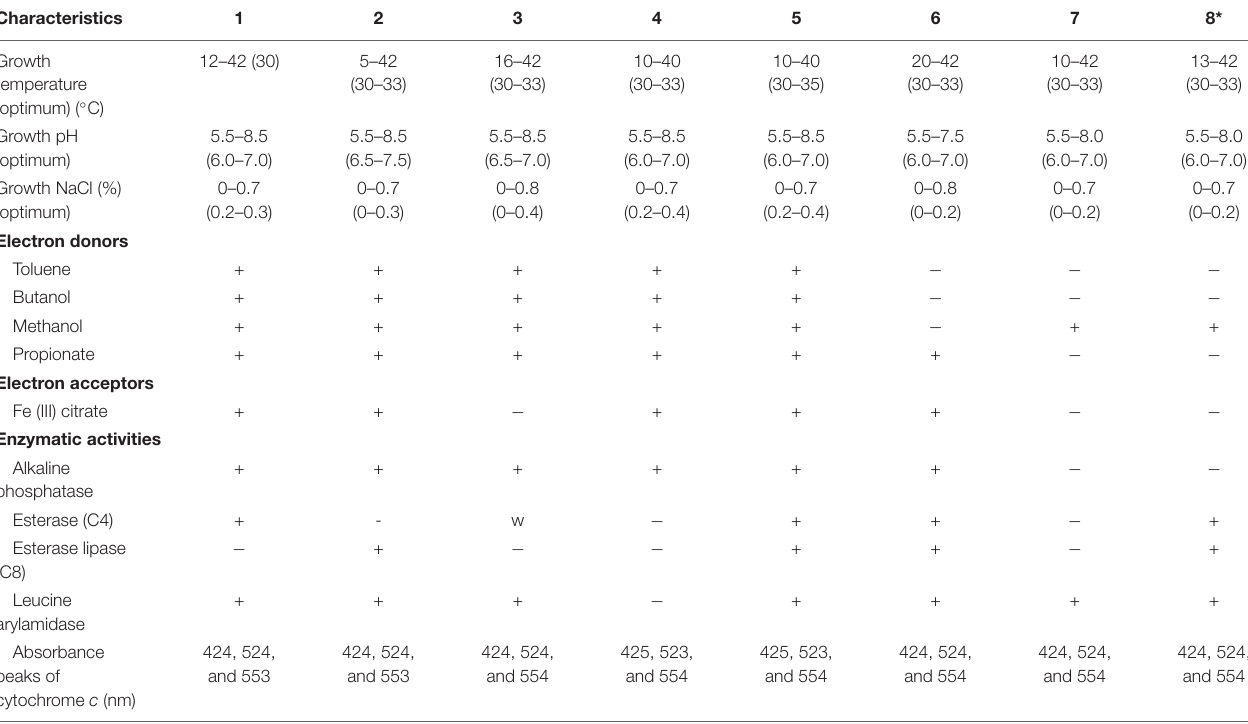
TABLE 1 | Differential characteristics of five isolated strains and closely related members of the genus Geomonas